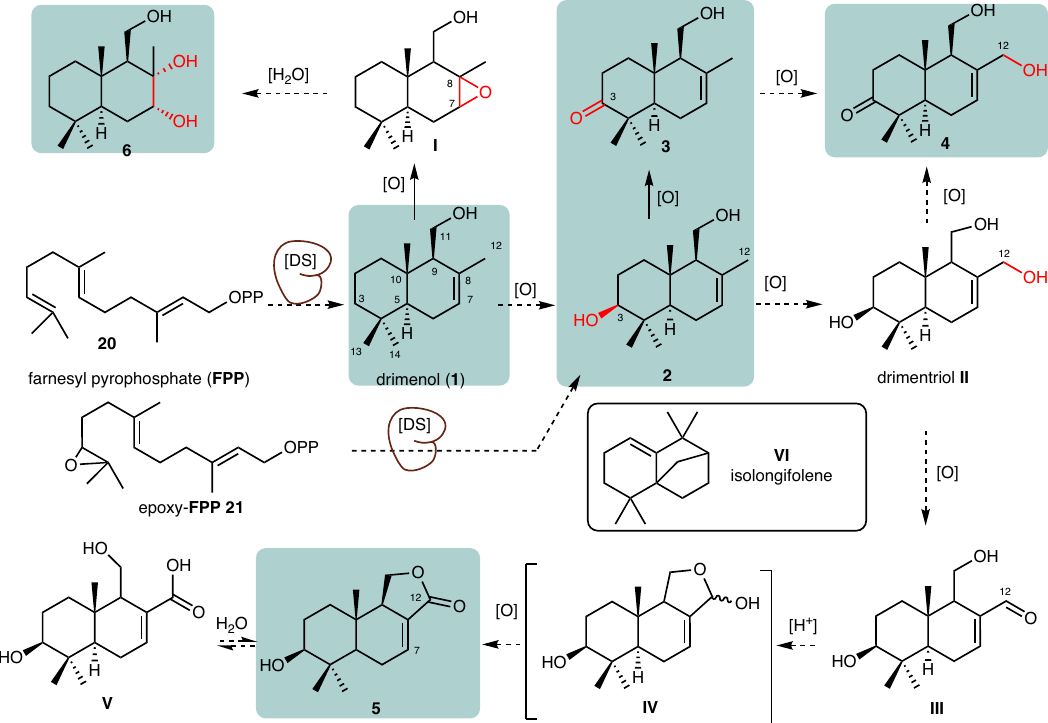
Fig. 6 Putative biosynthetic formation of drimane skeleton and drimenol congeners. Detected derivatives 1 - 6 from cultures of Termitomyces spp. are highlighted in blue boxes. A putative drimenol synthase [DS] is proposed to catalyze the cyclization of farnesyl pyrophosphate (FPP) or epoxy-FPP to yield drimenol ( 1 ) or 3-hydroxy drimenol ( 2 ). Enzymatic oxidative transformations [O] and hydrolytic steps are proposed to catalyze the transformation to the identi fi ed oxidized drimane and drimenol derivatives via proposed intermediates ( I – V